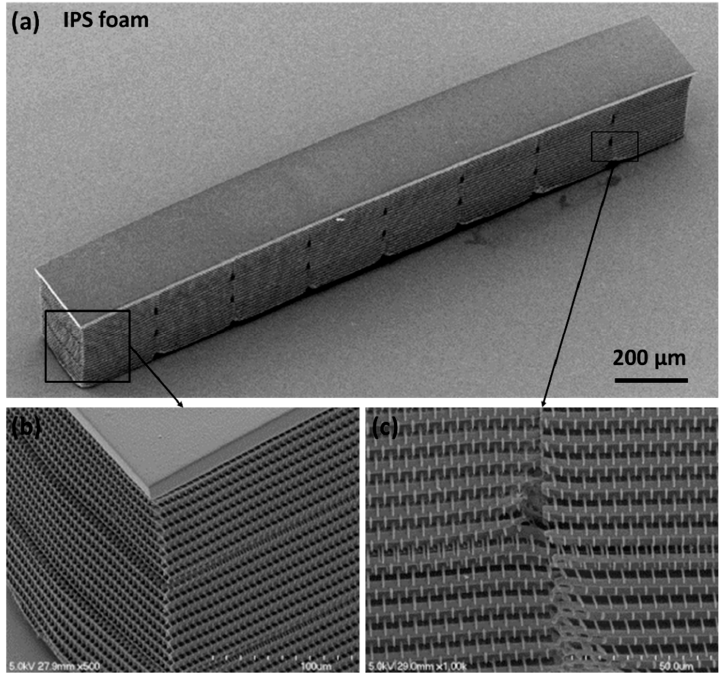
Figure 9 . SEM images of ( a ) 2 × 0.25 × 0.3 mm 3 foam rod with x, y, z cell dimensions of 6 × 6 × 3 μ m 3 and